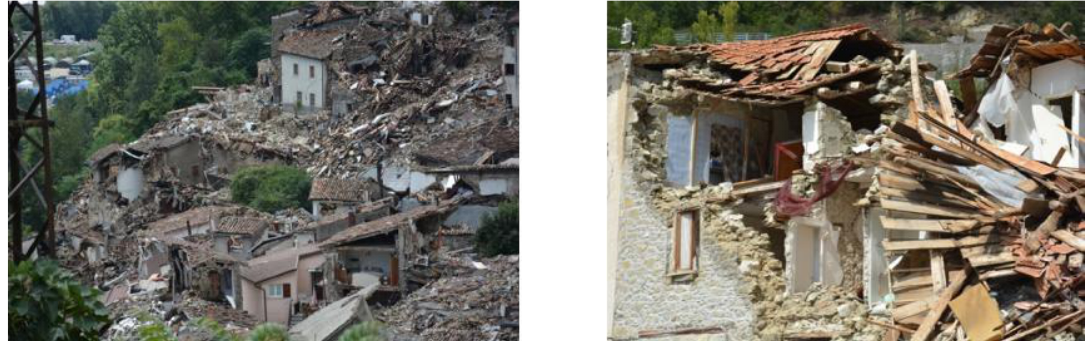
Figure 2: a) Overview of Pescara del Tronto most damaged area and b) Collapse of a typical masonry